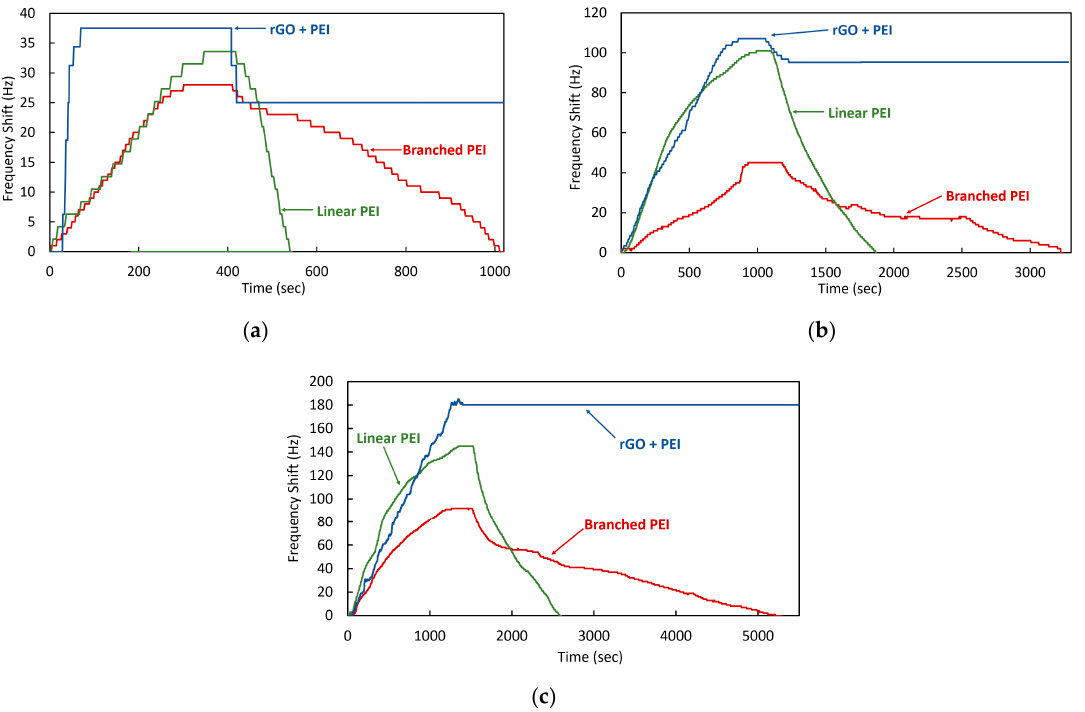
Figure 13. Response of the three different coatings at CO 2 concentrations of ( a ) 0.1 %, ( b ) 0.5 %, and ( c ) 1 %.